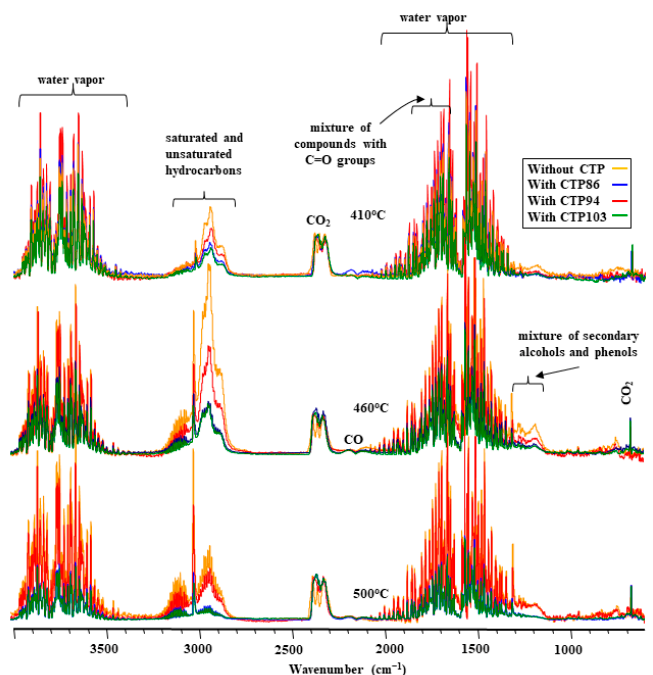
Figure 5. FT-IR spectra of volatile products emitted from coal and its blends with CTPs at pyrolysis temperatures of 410 °C, 460 °C, and 500 °C.